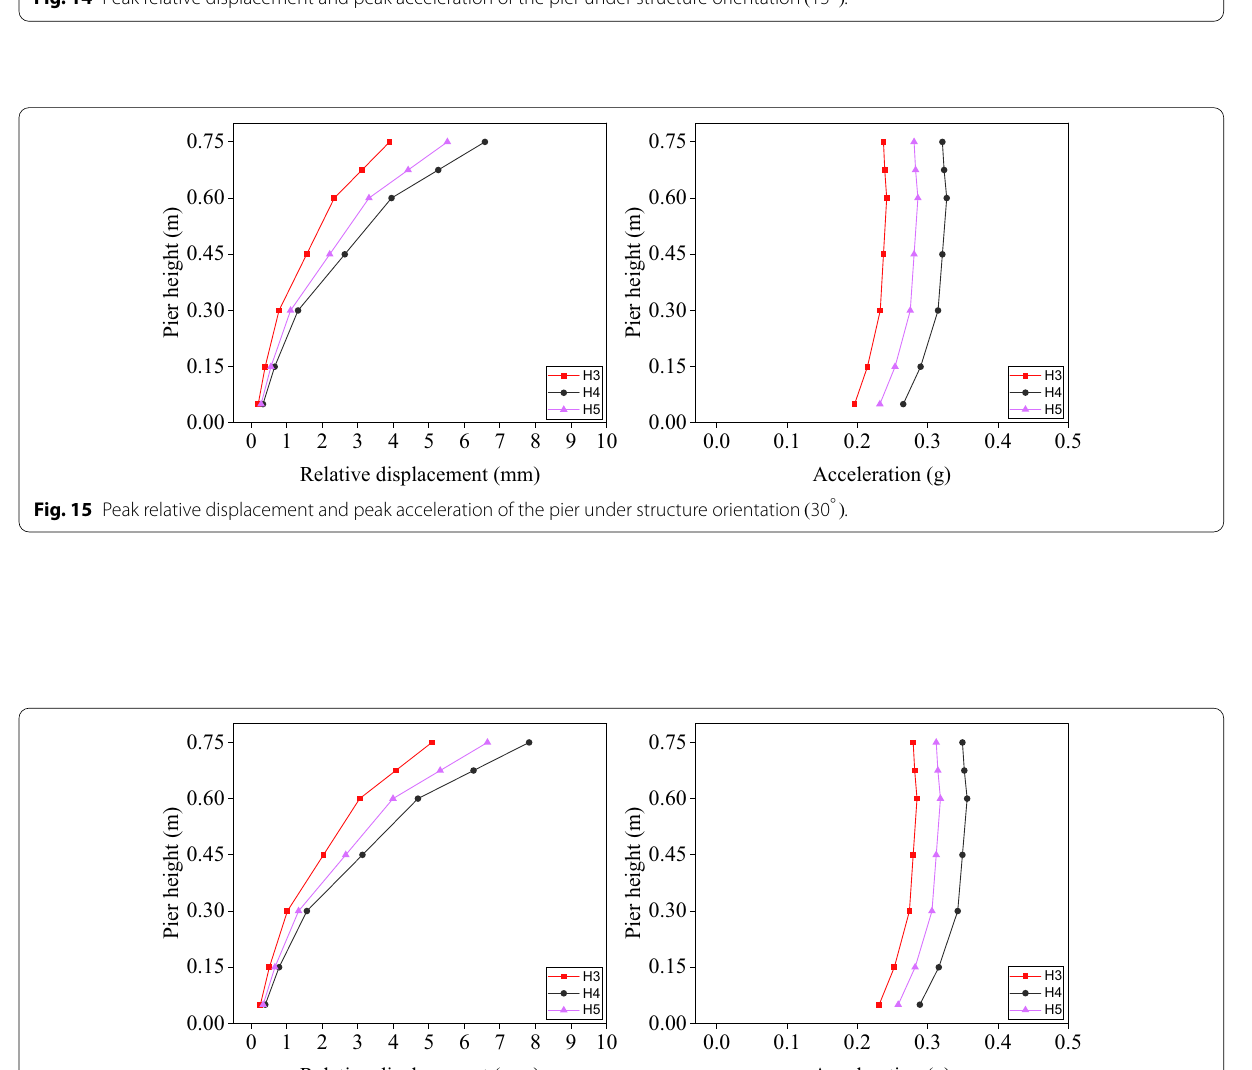
Fig. 14 Peak relative displacement and peak acceleration of the pier under structure orientation ( 15